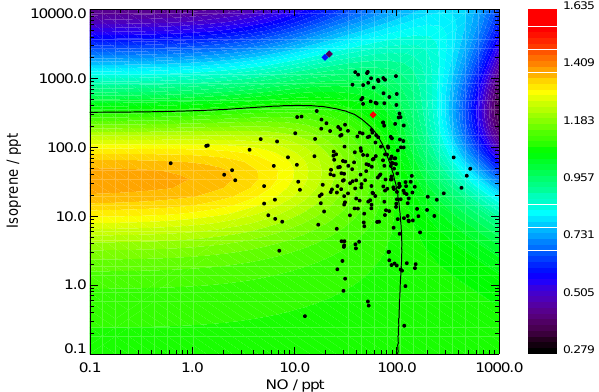
Fig. 8. Simplified schematic showing processes controlling radical budgets during AMMA. Bold lines indicate the dominant reactions in isoprene oxidation chemistry during AMMA. Fig. 9. Contour plot showing the fractional changes in modelled HO 2 at different NO and isoprene concentrations relative to a model run where the isoprene concentration was a factor of ten lower (the y-axis refers to the lower isoprene concentrations). Model runs described here were unconstrained to HCHO and isoprene degradation products. The 1:1 ratio for the modelled HO 2 concentrations is shown by the black line. Black circles indicate NO and isoprene concentrations encountered during AMMA, with the average conditions for AMMA shown by the red diamond. The blue diamond indicates the average NO and isoprene concentrations encountered during GABRIEL (Lelieveld et al., 2008) and the purple diamond the median isoprene and NO concentrations encountered during INTEX-A when isoprene was above 2 ppb (http://www-air.larc.nasa.gov/missions/intexna/intexna.htm).